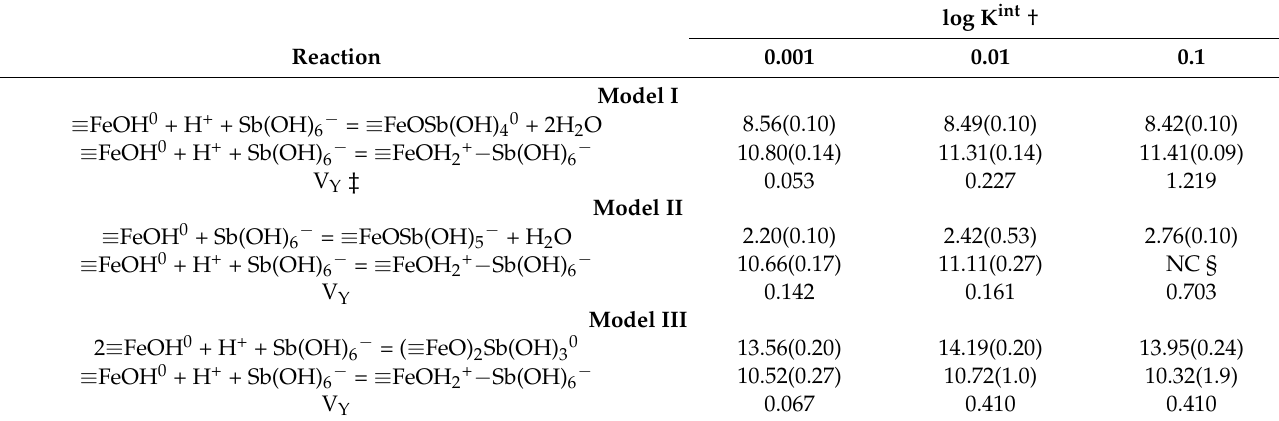
Table 1. The optimized triple layer surface complexation models that describe the adsorption of antimony by hematite as a function of pH and ionic